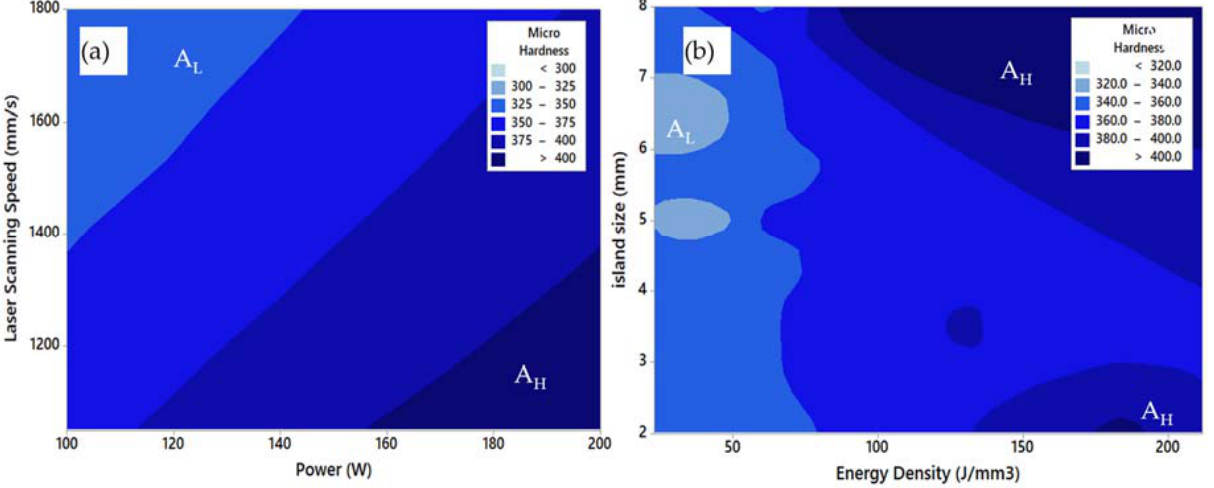
Figure 12. ( a ) Low and ( b ) high magnification SEM micrographs of the HIPed samples.